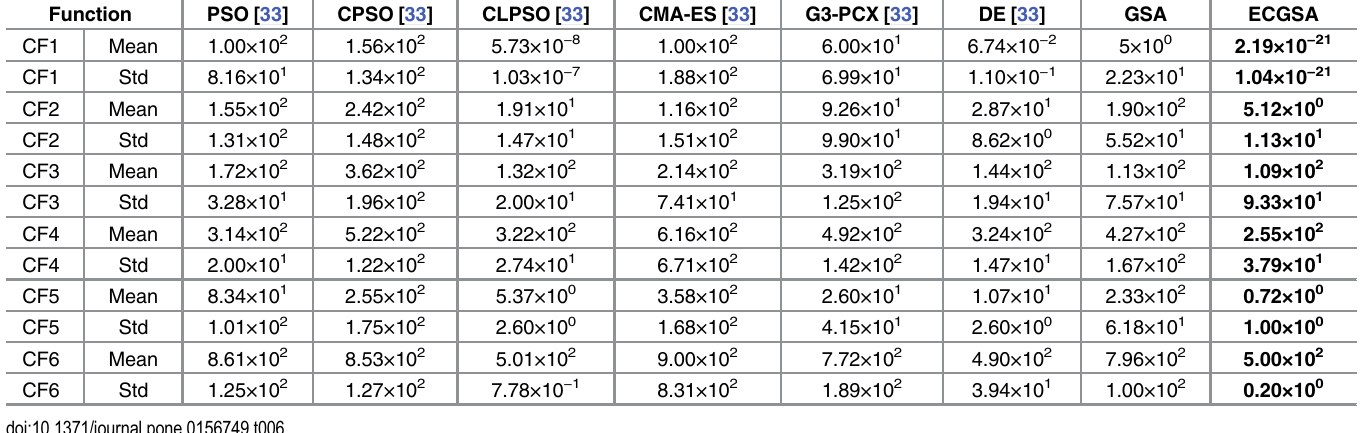
Table 6. Composition tests functions.